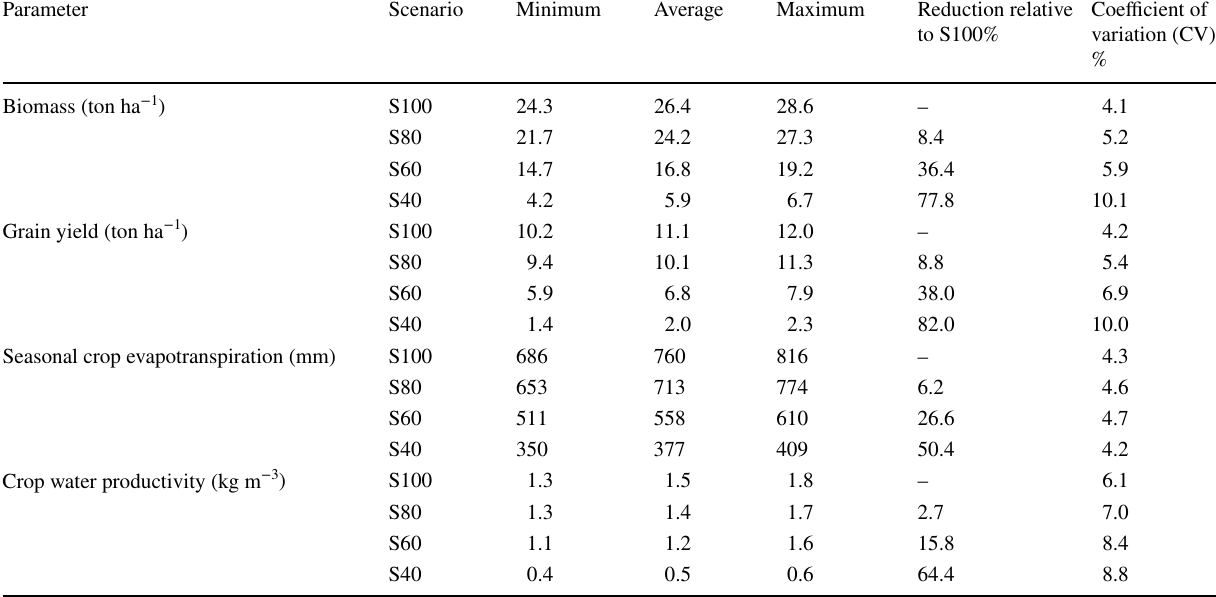
Table 1 Statistical summary of the studied parameters in the temporal analysis for the whole study area Parameter Scenario